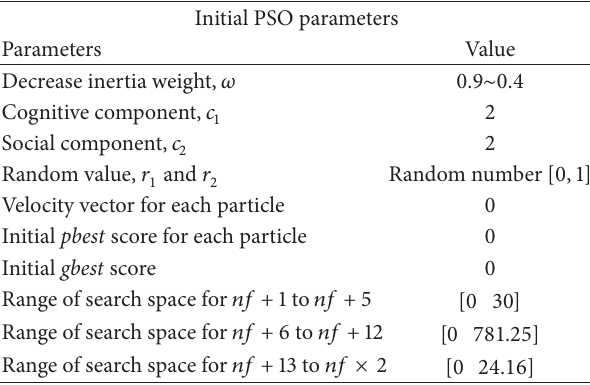
Table 5: Parameters setting of standard PSO and RA-PSO algo-